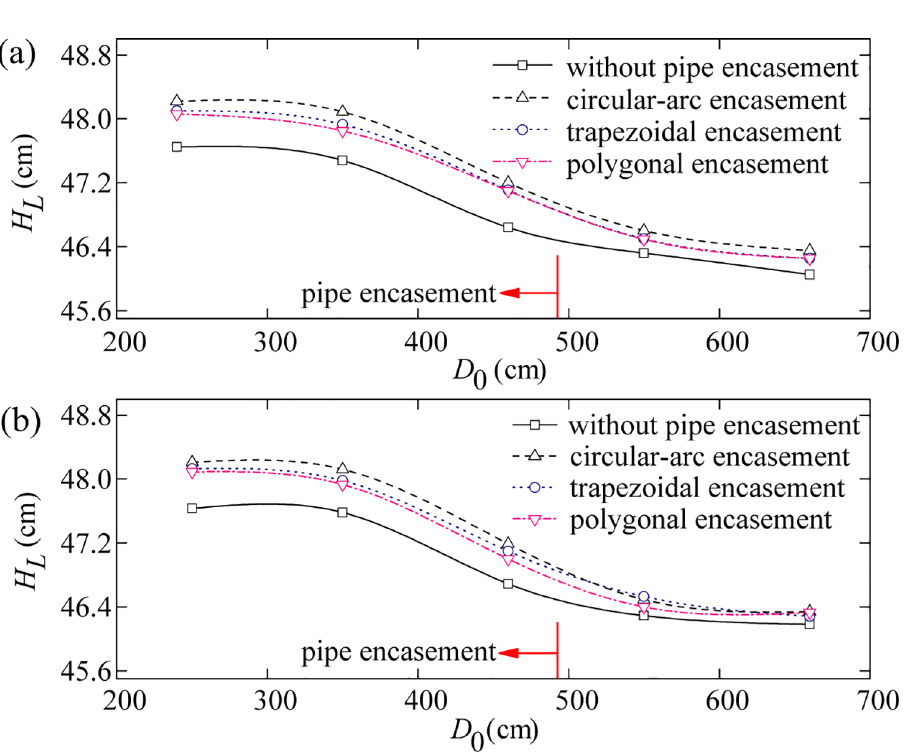
Fig 5. Water level curves on the left bank (a) and the right bank (b) for a 3-year flood event.